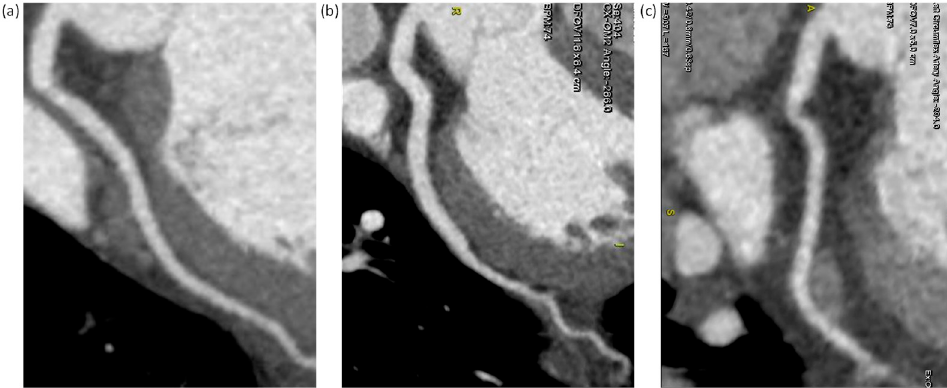
Figure 1. Curved multiplanar reformations of the left circumflex artery (LCX) subjectively rated at 1, 2, and 3 (left to right). ( a ) Heart rate (HR) = 61 bpm, body mass index (BMI) = 21.8 kg/m 2 , and noise index (NI) = 24 HU; ( b ) HR = 74 bpm, BMI = 27.7 kg/m 2 , and NI = 27.7 HU; ( c ) HR = 73 bpm, BMI = 31.1 kg/m 2 , and NI = 30.4 HU.